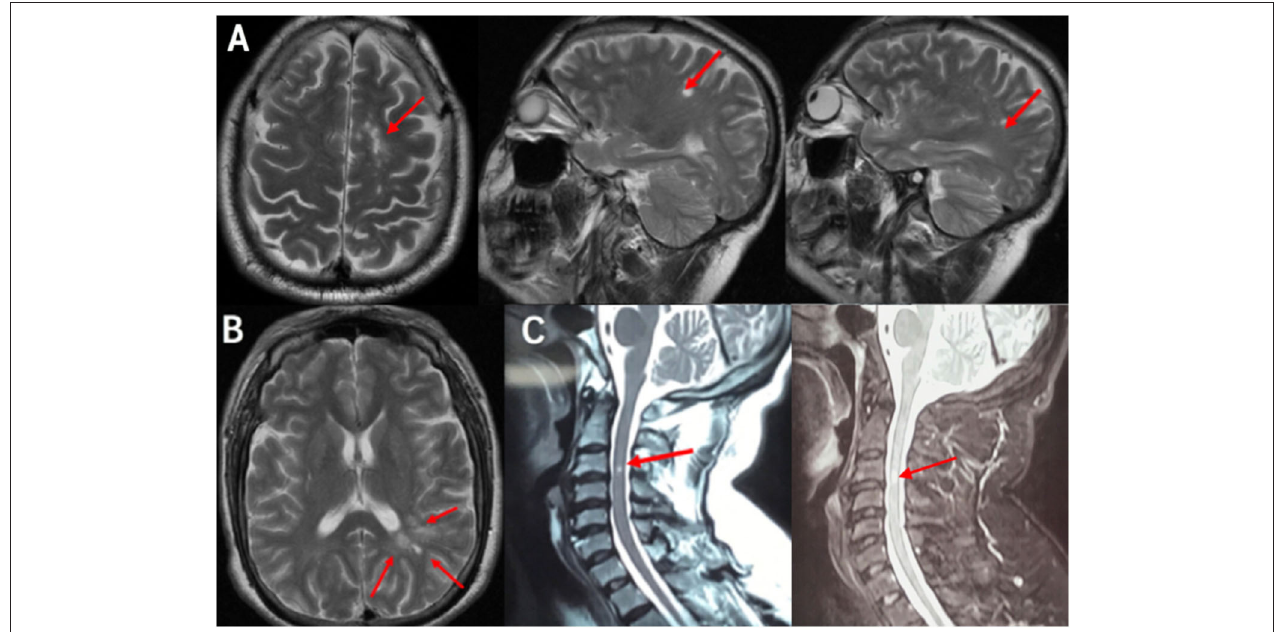
FIGURE 1 | MRI scan demonstrated the DIS: (A) Cranial MRI T2 scans revealed three lesions in the cortex and juxtacortical lesions. (B) Cranial MRI T2 scans revealed multiple white-matter lesions in the periventricular lesion. (C) Cervical MRI scans revealed a cervical 3rd segment with hyperintensity signal in T2 and enhanced T2. Red arrows showed lesions, which was preliminary diagnosed demyelination. MRI, magnetic resonance imaging; DIS, dissemination of lesions in space.